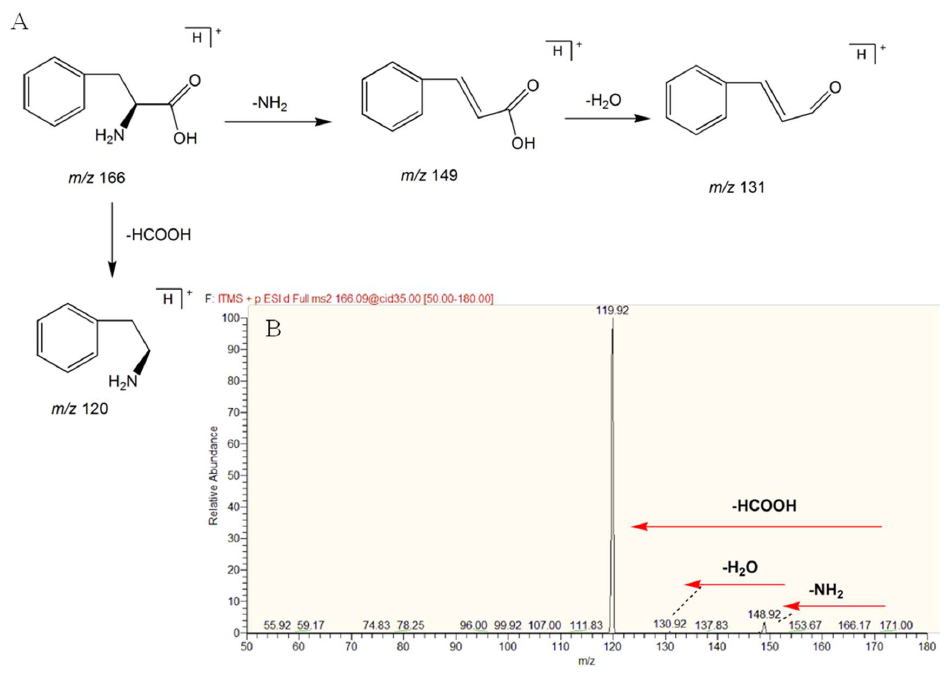
Figure 5. ( A ) Fragmentation pathway and product ion spectrum of L-phenylalanine; ( B ) MS/MS spectrum of L -phenylalanine by mzCloud.